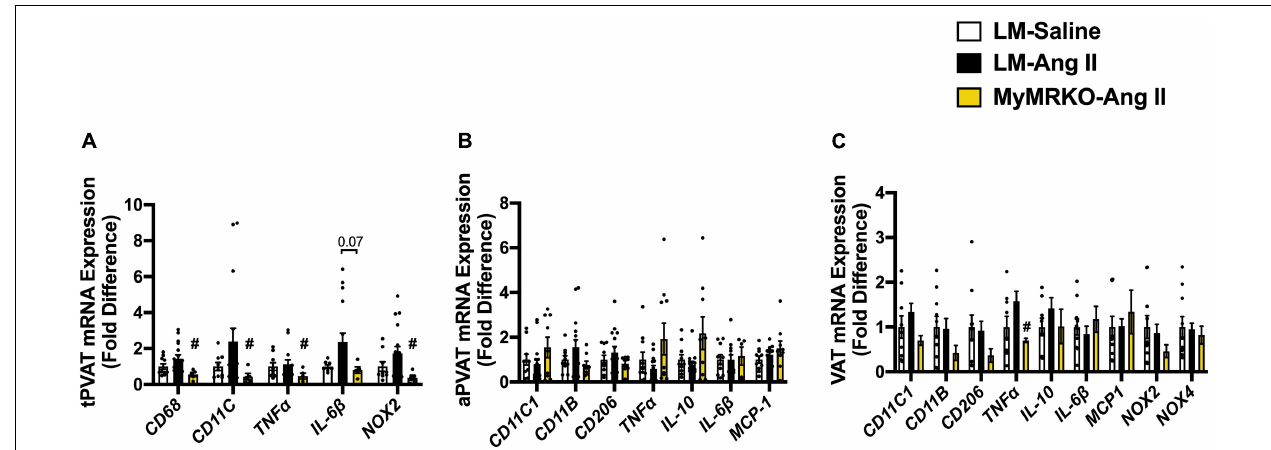
FIGURE 5 | Markers of macrophage infiltration and polarization in different fat depots. (A) Thoracic perivascular adipose tissue (tPVAT), (B) abdominal perivascular adipose tissue (aPVAT), and (C) visceral adipose tissue (VAT). Total macrophage expression (CD11b), M1 macrophage expression (MCP-1), and M2 macrophage polarization (IL-10). # p ≤ 0.05, LM-Ang II vs. MyMRKO-Ang II. n = 9–10 for all groups. LM, littermate; Ang II, angiotensin II; MyMRKO, myeloid mineralocorticoid receptor knockout.